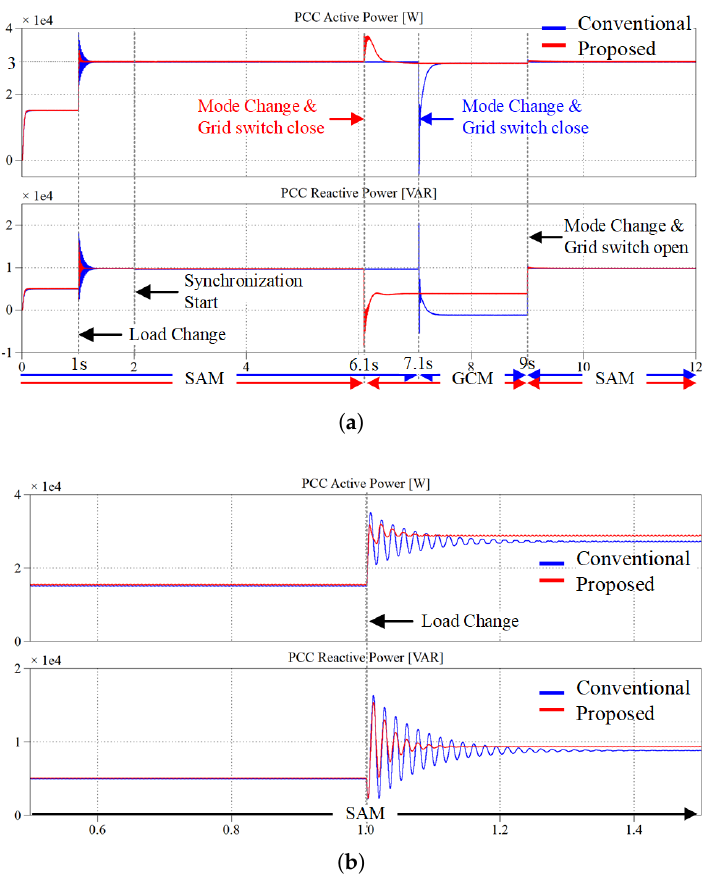
Figure 9. Simulation result of conventional (blue line) and proposed (red line) synchronverter control method with parallel R-L load condition from SAM to GCM ( a ) overall sequence, ( b ) load change. The power oscillation may cause an instability in multiple interfaced converters